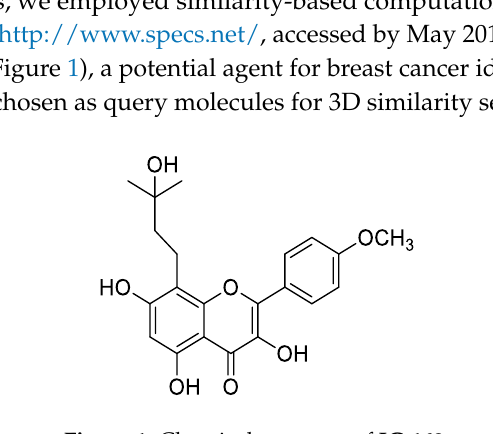
Figure 1. Chemical structure of IC-163 .